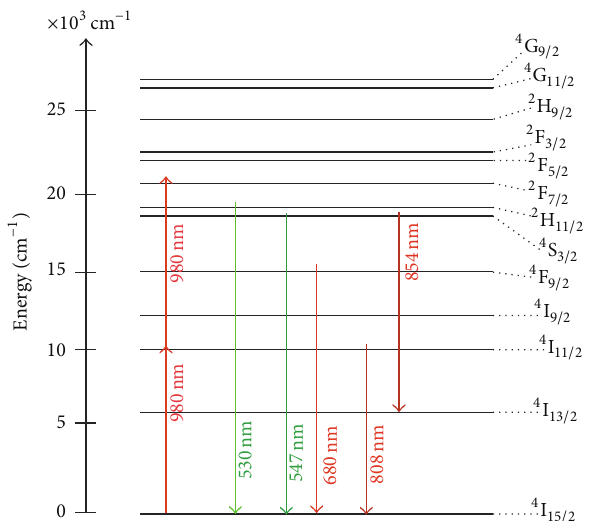
Figure 15: Simplified Er energy levels diagram illustrating the- upconversion process by energy transfer and by excited state absorption .